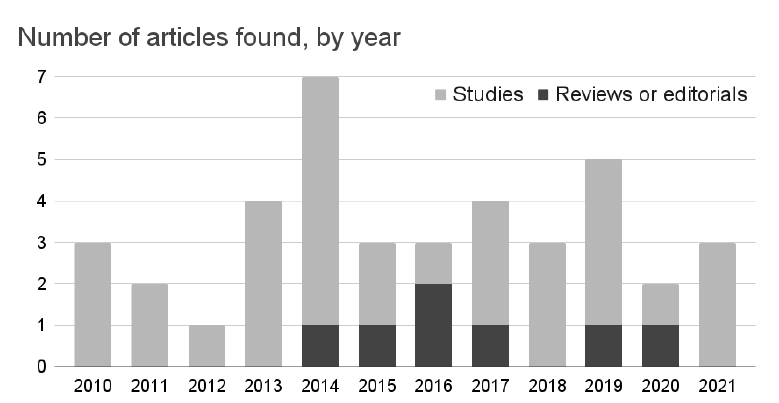
Figure 1. Number of articles found in literature review, by year and